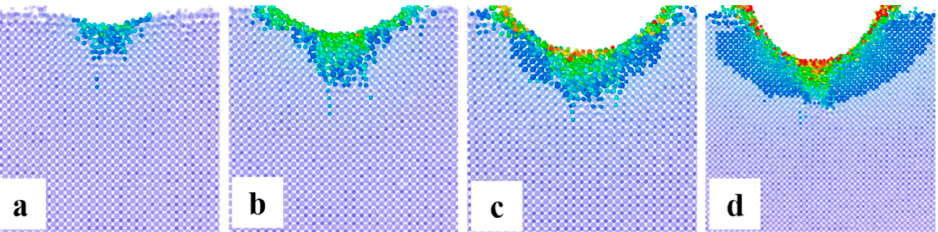
Figure 14. Center cross-section views of structural evolution at the indentation depth of ( a ) 3.0 Å, ( b ) 6.0 Å, ( c ) 10.5 Å and ( d ) 18.0 Å.